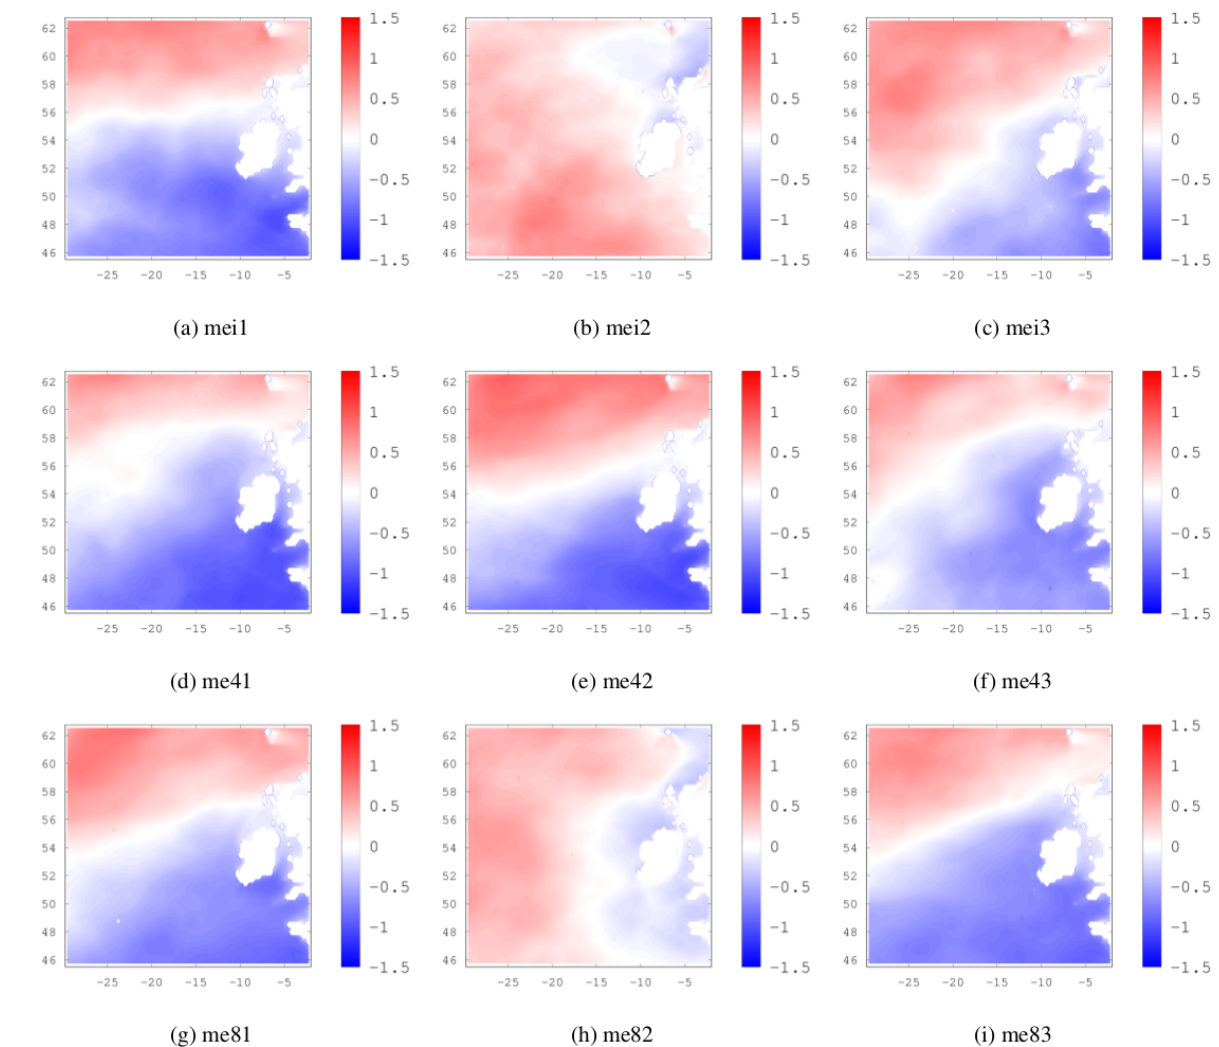
Figure B2. Maximum likelihood estimate of the µ 3 parameter. The three ensemble members are shown for the historical period (a) to (c) , future period under RCP4.5 (d) to (f) , and future period under RCP8.5 (g) to (i)